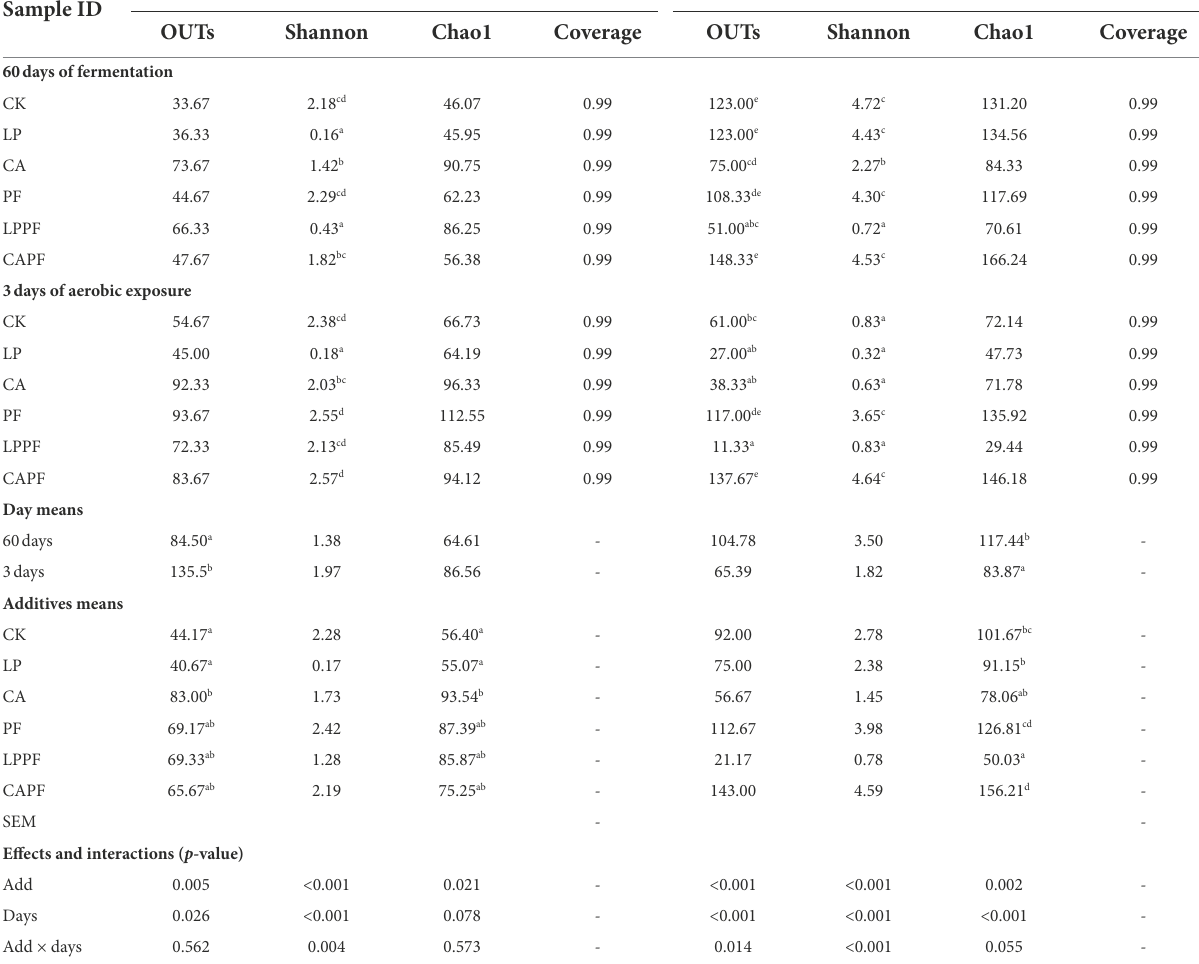
TABLE 4 The microbial diversity of forage oat silages during aerobic exposure.